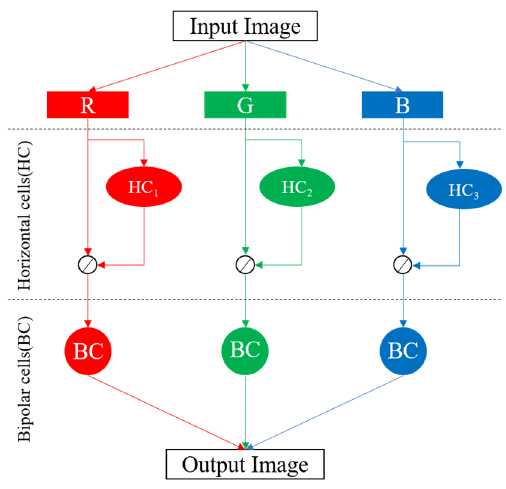
Figure 1. The structure of the algorithm model [8]. Table 1. Filter selection according to the value range of pixel.